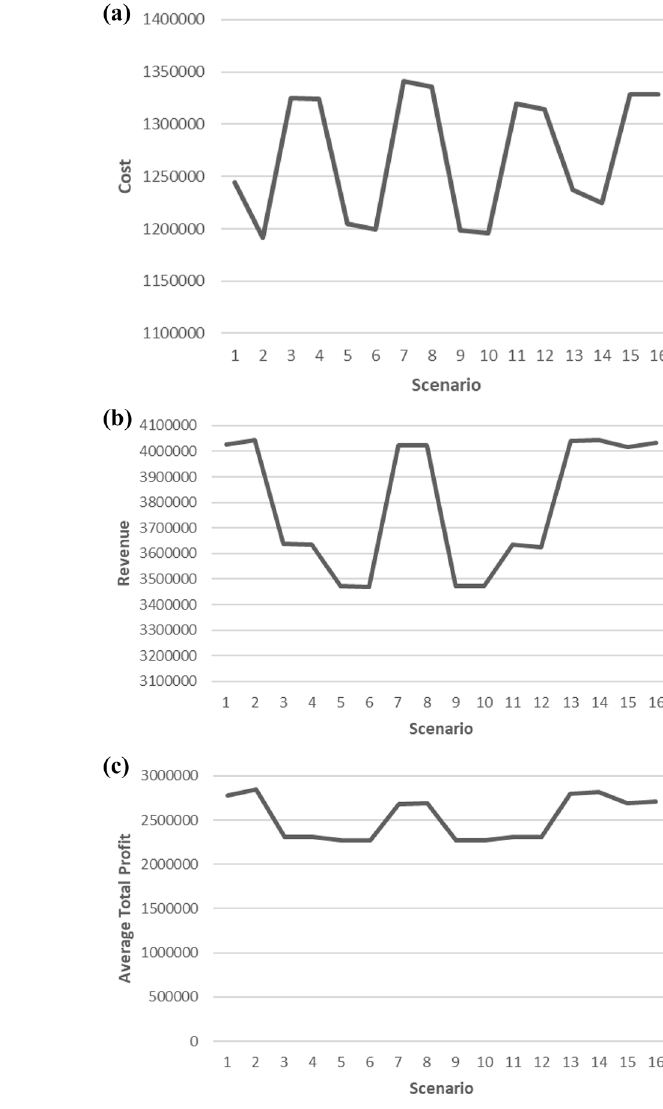
Fig. 9 a Average total cost. b Average total sales revenue. c Average total